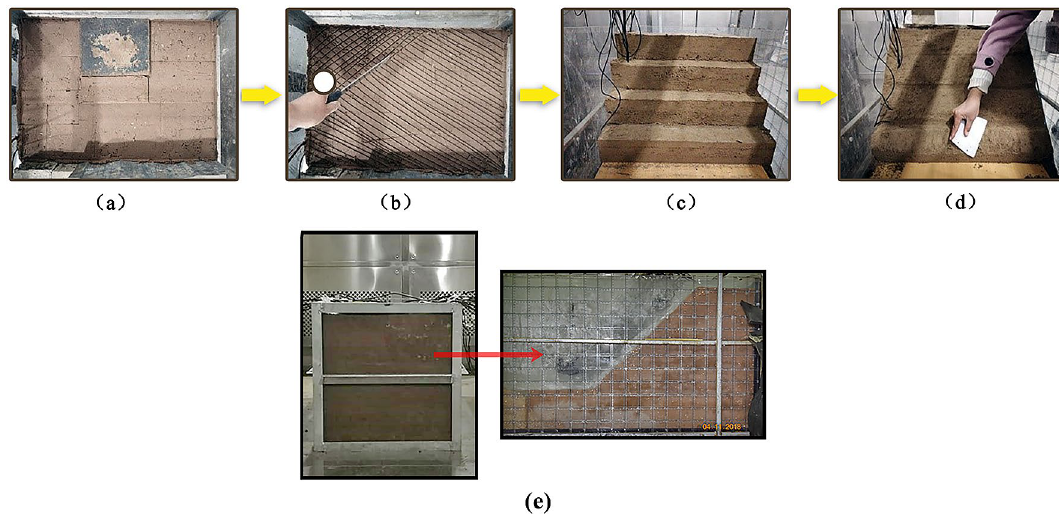
Figure 1. Slope preparation process (( a ) layered compaction; ( b ) surface scraping; ( c ) dismantling support; ( d ) slope cutting; ( e ) finished preparation).